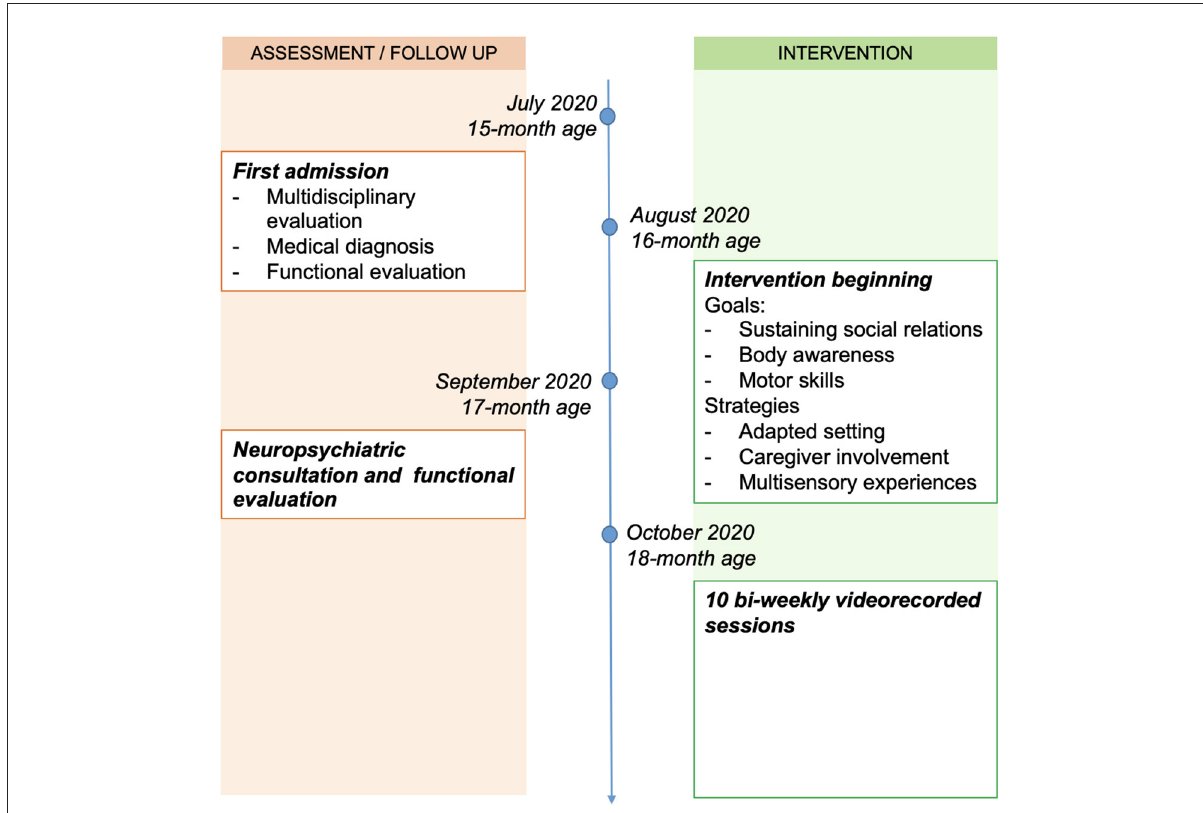
FIGURE1 Timeline of the case clinical assessment and